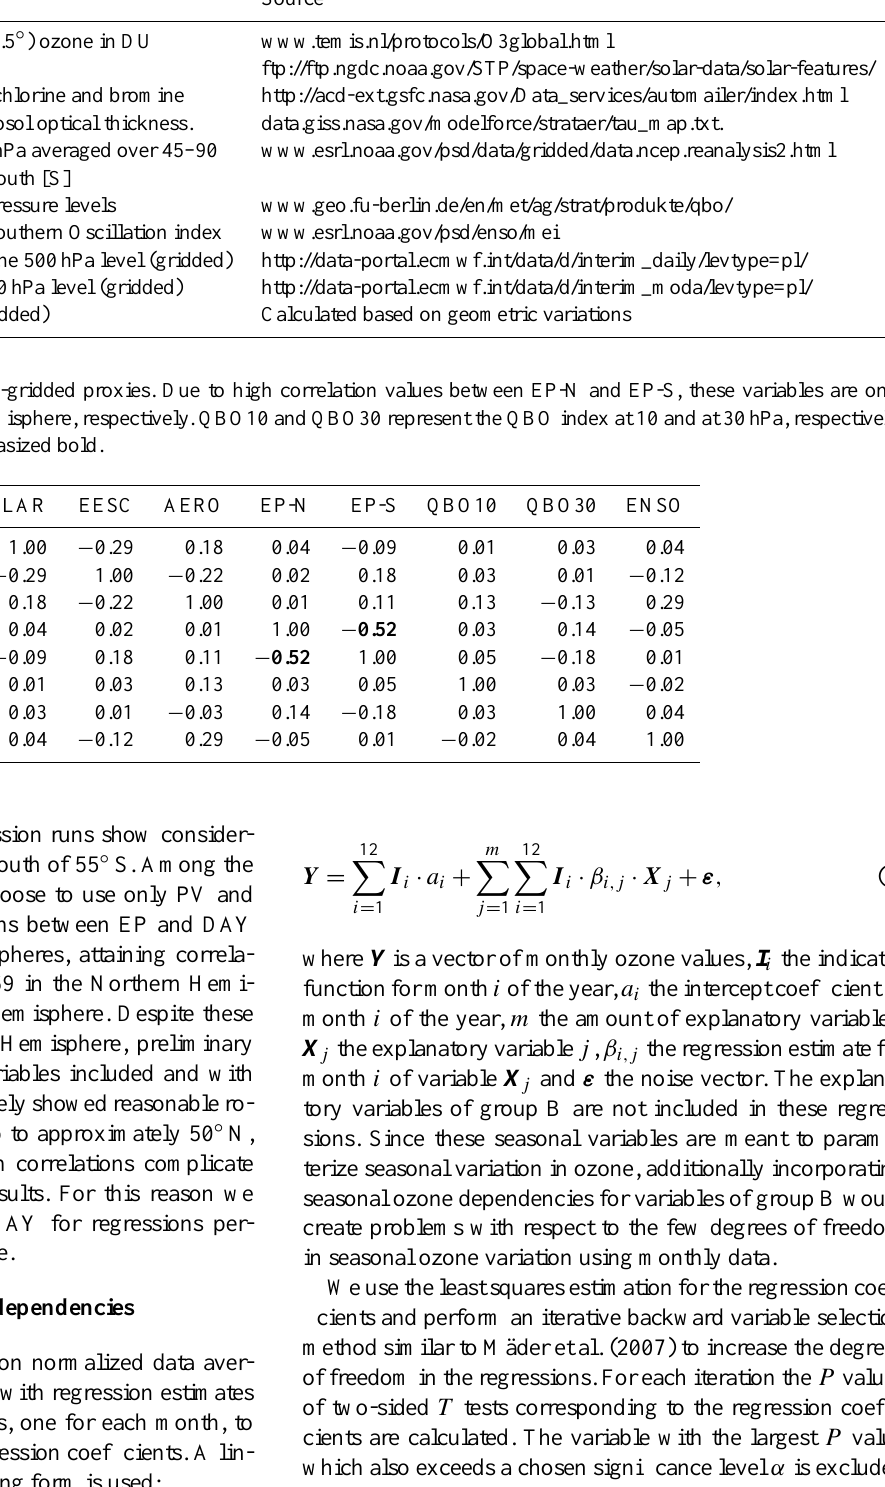
Table 1. List of variables and their sources. Proxy